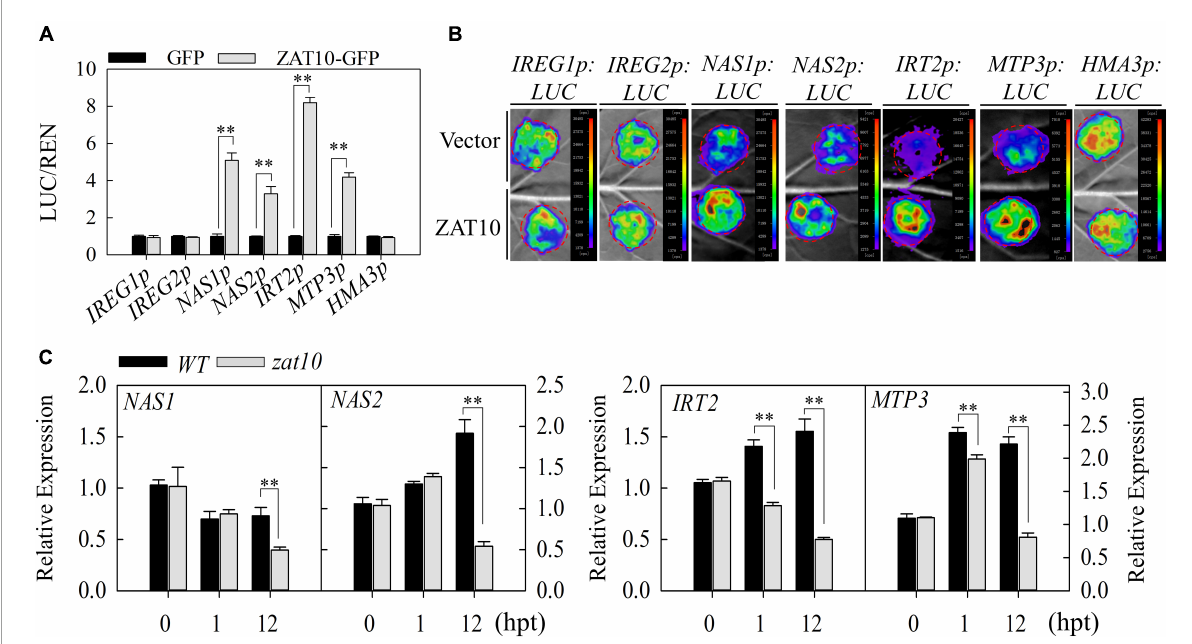
FIGURE5 ZAT10 activates the expression of NAS1 , NAS2 , IRT2 , and MTP3 . (A) Dual-luciferase assays in Arabidopsis protoplasts show that additional ZAT10 enhances the activity of NAS1p:LUC , NAS2p:LUC , IRT2p:LUC , and MTP3p:LUC in protoplast transient expression assays. The REN was used as an internal control. LUC/REN ratio represents the relative activity of the IREG1 , IREG2 , NAS1 , NAS2 , IRT2 , MTP3 , and HMA3 promoters. Means ± SD, n = 3; ∗∗ P < 0.01, Student’s t -test. (B) ZAT10 enhances the transcriptional activity of NAS1 , NAS2 , IRT2 , and MTP3 promoters in N. benthamiana leaves. The IREG1p:LUC , IREG2p:LUC , NAS1p:LUC , NAS2p:LUC , MTP3p:LUC , and HMA3p:LUC were co-infiltrated with empty vector or ZAT10 overexpression vector in N. benthamiana leaves as indicated. Images were taken at 48 h after infiltration. At least three replicates were measured with similar results. (C) Relative expression levels of NAS1 , NAS2 , IRT2 , and MTP3 in the wild-type and zat10 mutant plants at 0, 1, and 12 h post treatment (hpt) with 30 µ M CdSO 4 . Means ± SD, n = 3; ∗∗ P < 0.01, Student’s t